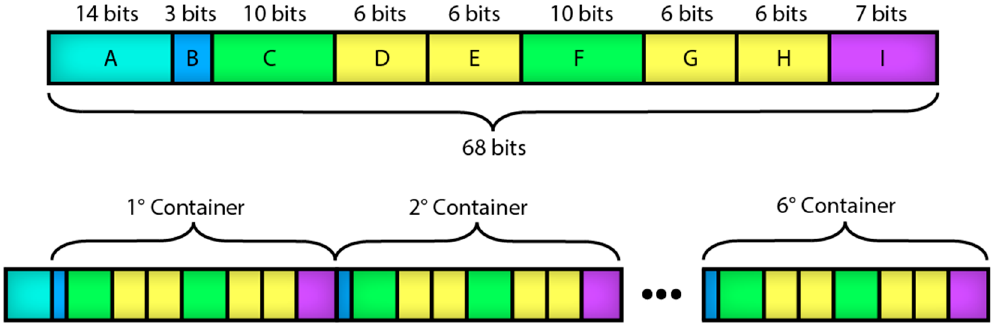
Figure 8. Structure of the data frame per routine of the mobile app. Table 3. Components of the data frame used in the mobile app.